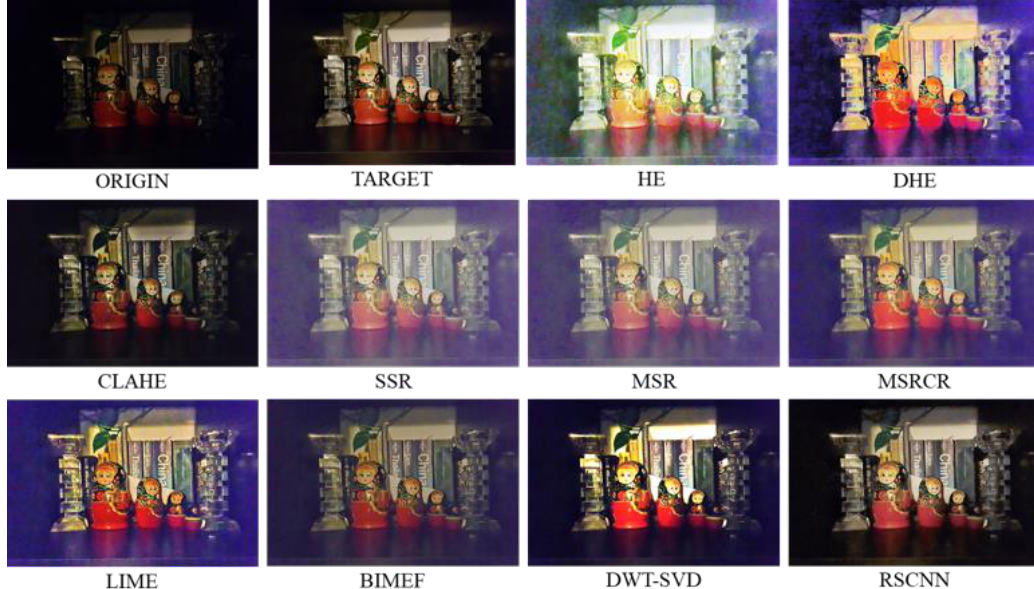
Figure 4. Image-enhancement results with different methods, including Histogram Equalization (HE), Dynamic Histogram Equalization (DHE), Contrast Constrained Adaptive Histogram Equalization (CLAHE), Single-scale Retinex (SSR), Multi-scale Retinex (MSR), Multi-scale Retinex with Color Restoration (MSRCR), Low-light Image Enhancement (LIME), Bio-Inspired Multi-Exposure Fusion (BIMEF), Discrete Wavelet Transform and Singular Value Decomposition (DWT-SVD), and RSCNN.